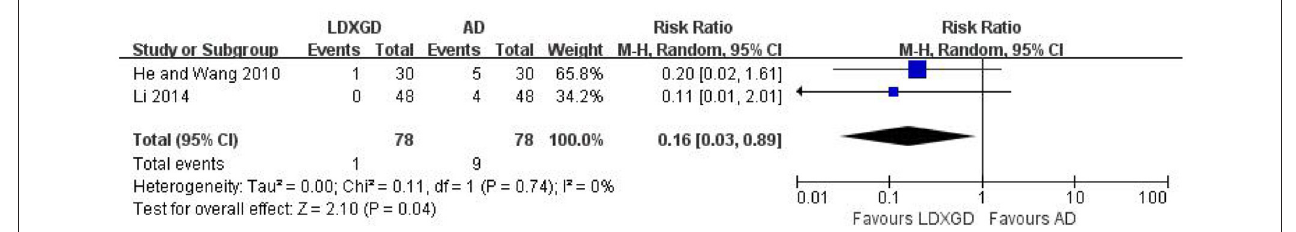
FIGURE 6 | Forest plot of the reported adverse effects. AD, antihypertensive drugs; LDXGD, longdanxiegan